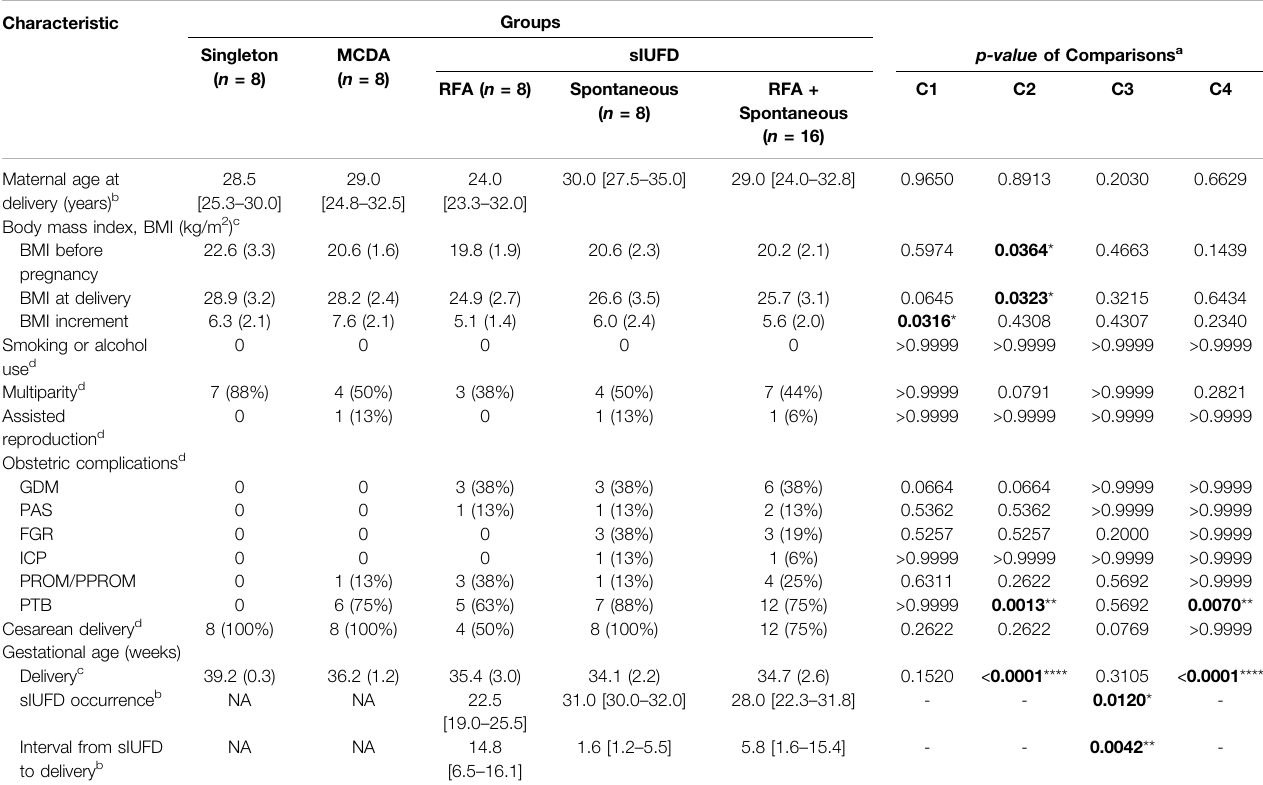
TABLE 1 | Demographic and clinical characteristics of